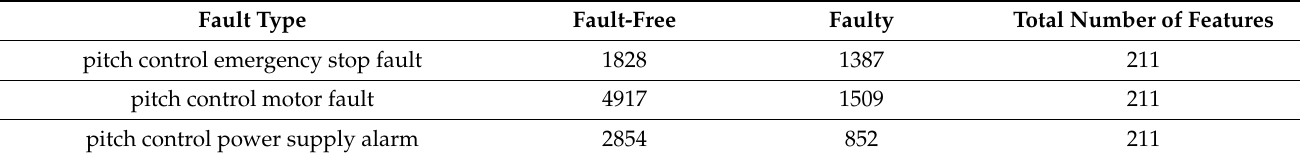
Table 2. Dataset description.